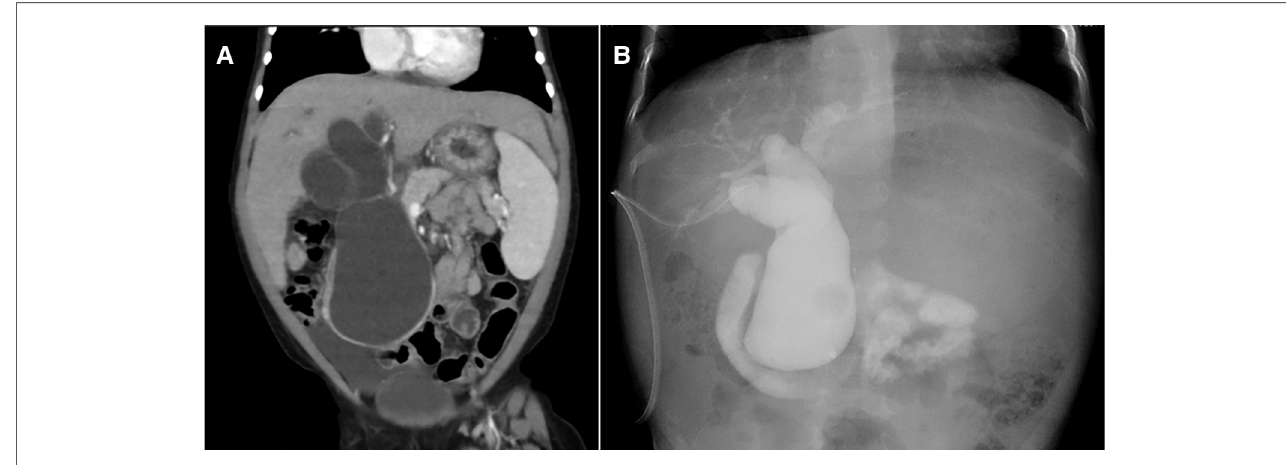
FIGURE 1 Diagnostic imaging fi ndings ( A ) contrast-enhanced computed tomography ( B )